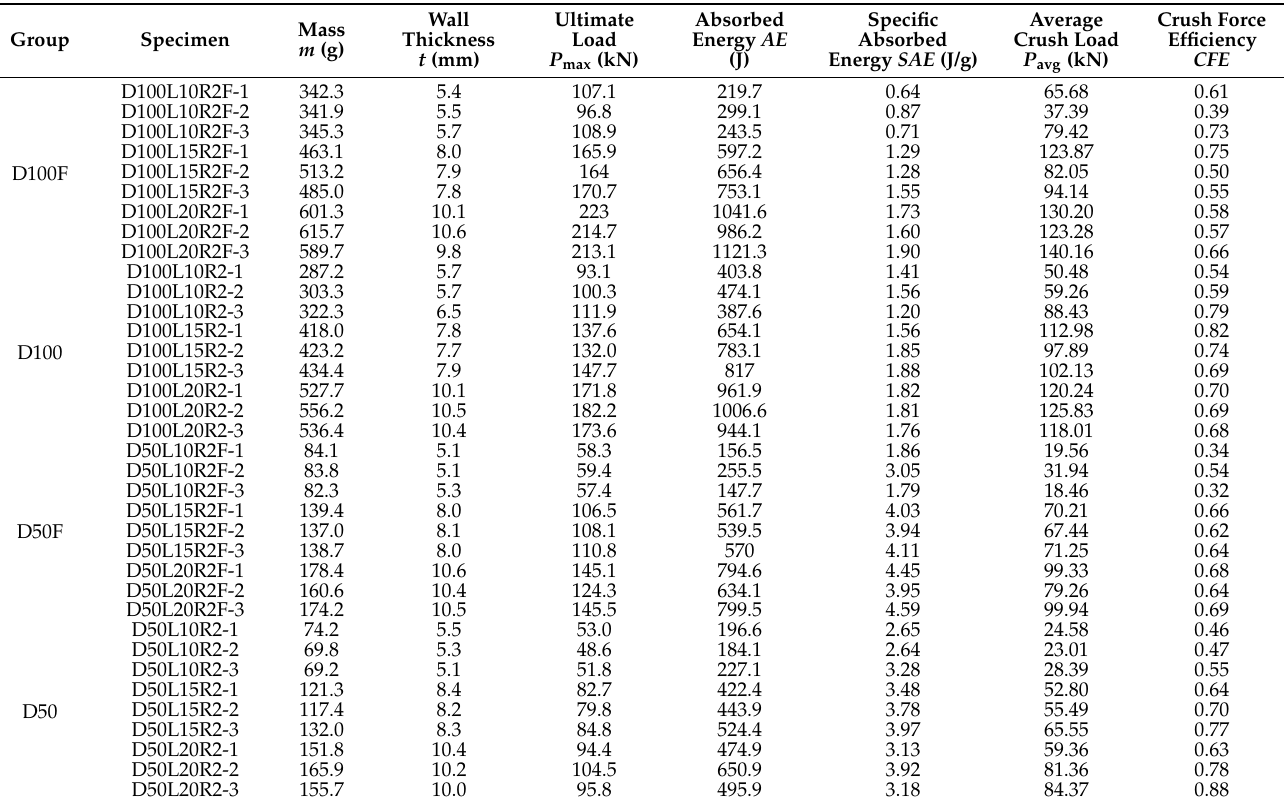
Table 5. Energy absorption indices of unfilled and foam-filled bamboo composite